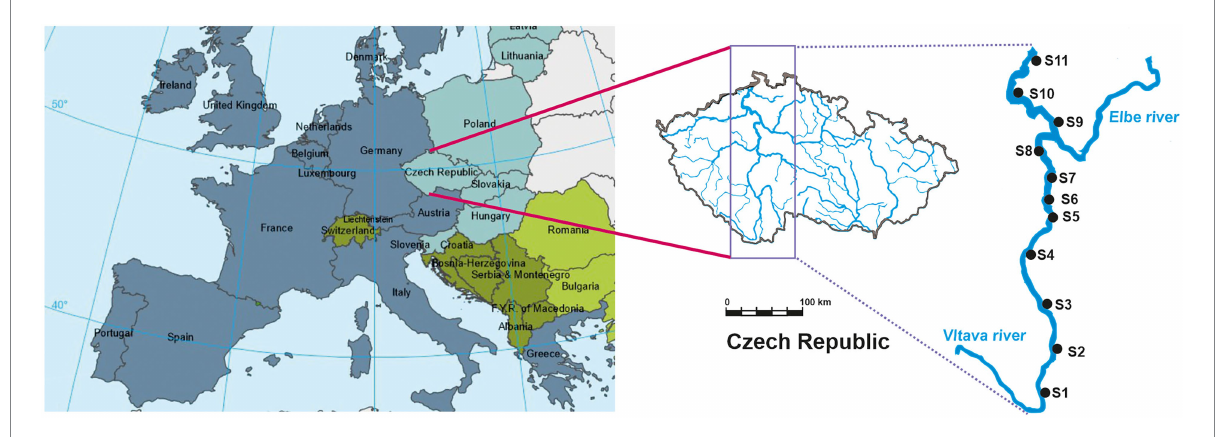
FIGURE 2 Location of sampling